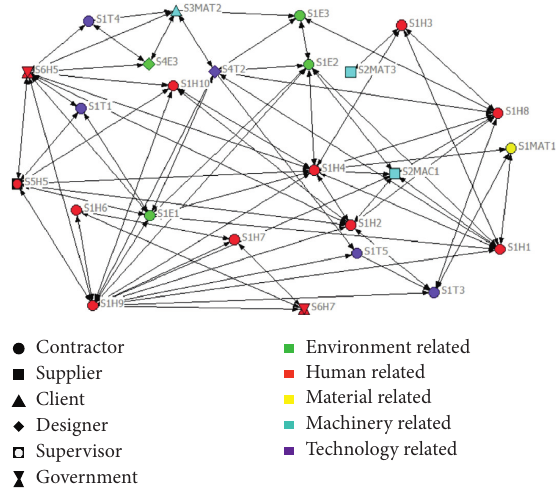
Figure 3: Social analysis network of safety risk factors. Table 8: Top 8 safety risk factors with high-degree centrality.